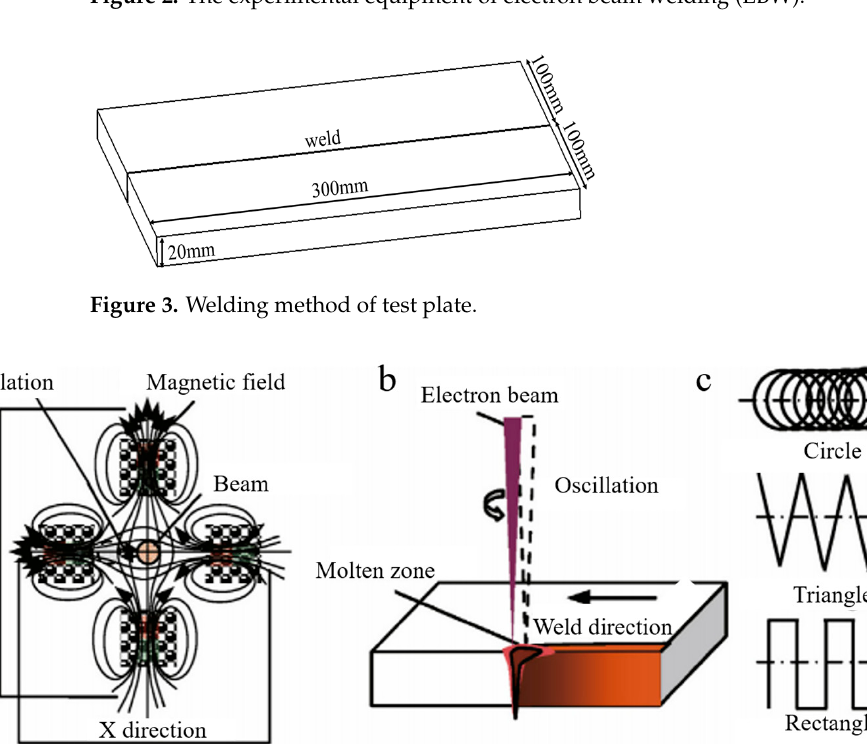
Figure 2. The experimental equipment of electron beam welding (EBW).